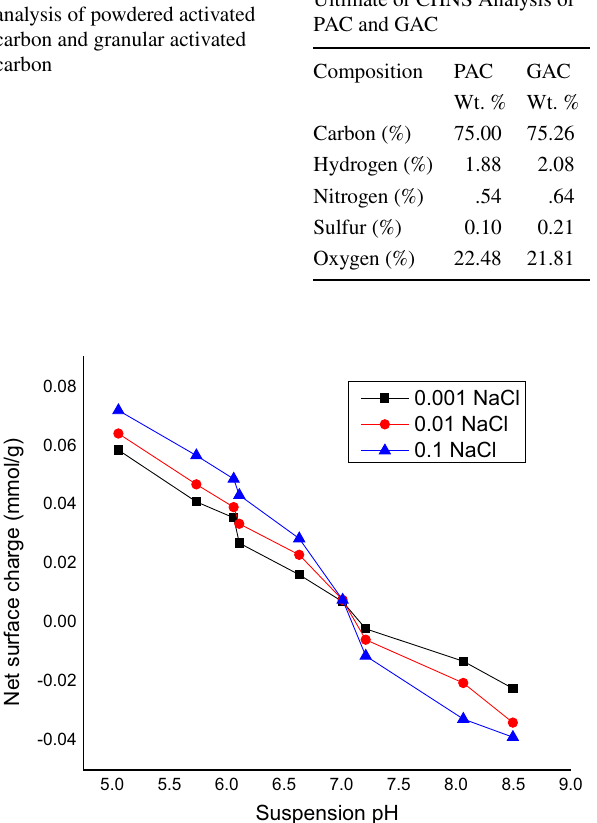
analysis of powdered activated carbon and granular activated